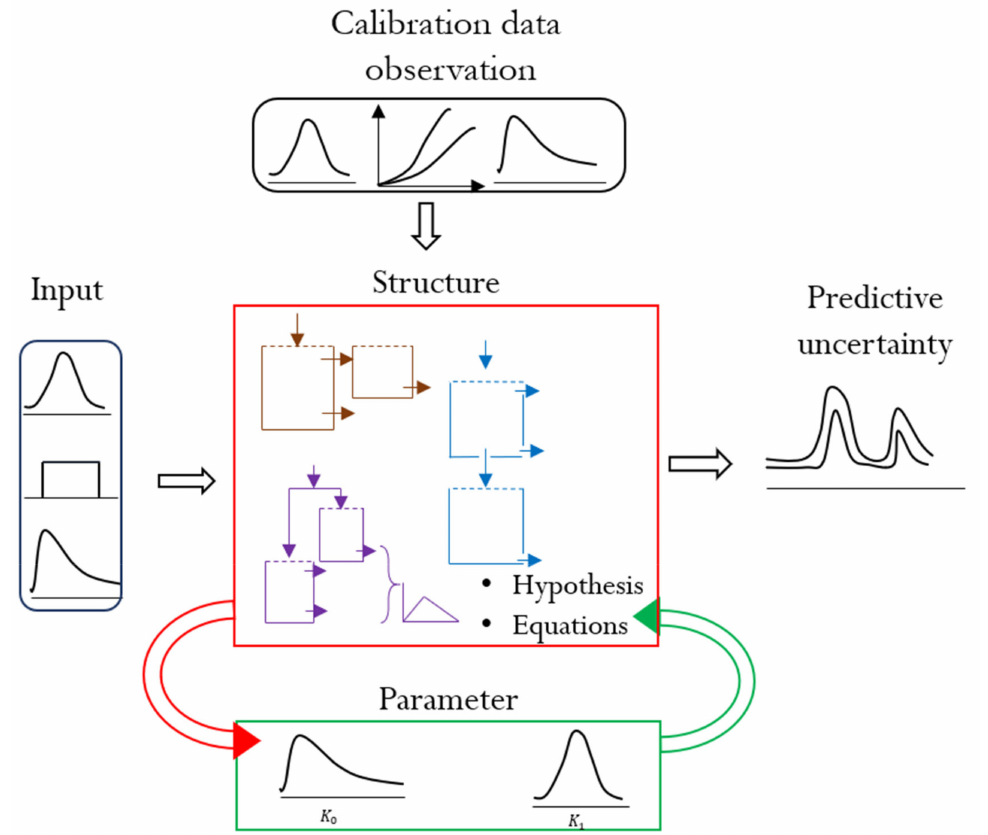
Figure 1. Different sources of hydrological model uncertainty. The arrows indicate the direction of interaction of the uncertainty sources. The center rectangle demonstrates different structures, hypotheses, and equations as examples of structural uncertainty. The top and left rectangles indicate input data distributions as sources of input forcing and calibration data uncertainties. The bottom rectangle shows parameter uncertainty using parameter distributions. The right-side sketch shows the resultant predictive uncertainty in a hydrograph as upper and lower predictive